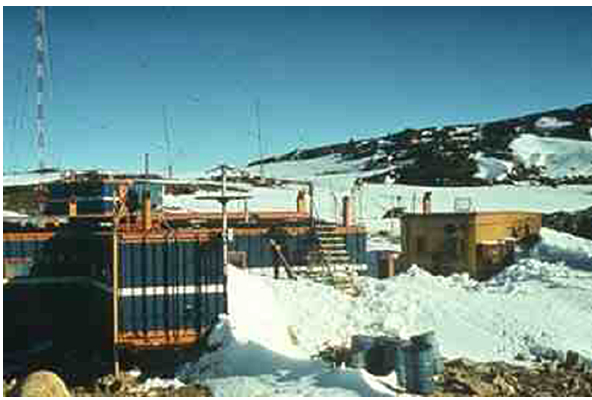
Figure 32. German station near New